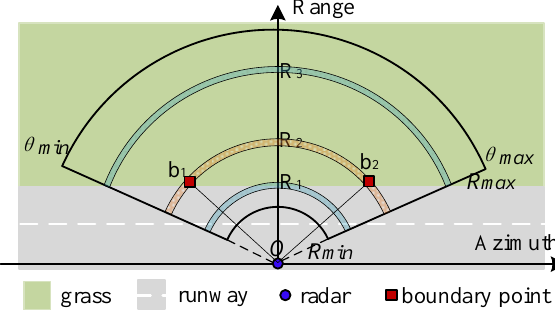
Figure 4. Complex background conditions are considered: homogeneous runway or grass surface is involved in range gate R 1 or R 3 ; clutter edges are generated by terrain discontinuity within the same range gate, as demonstrated by R 2 .